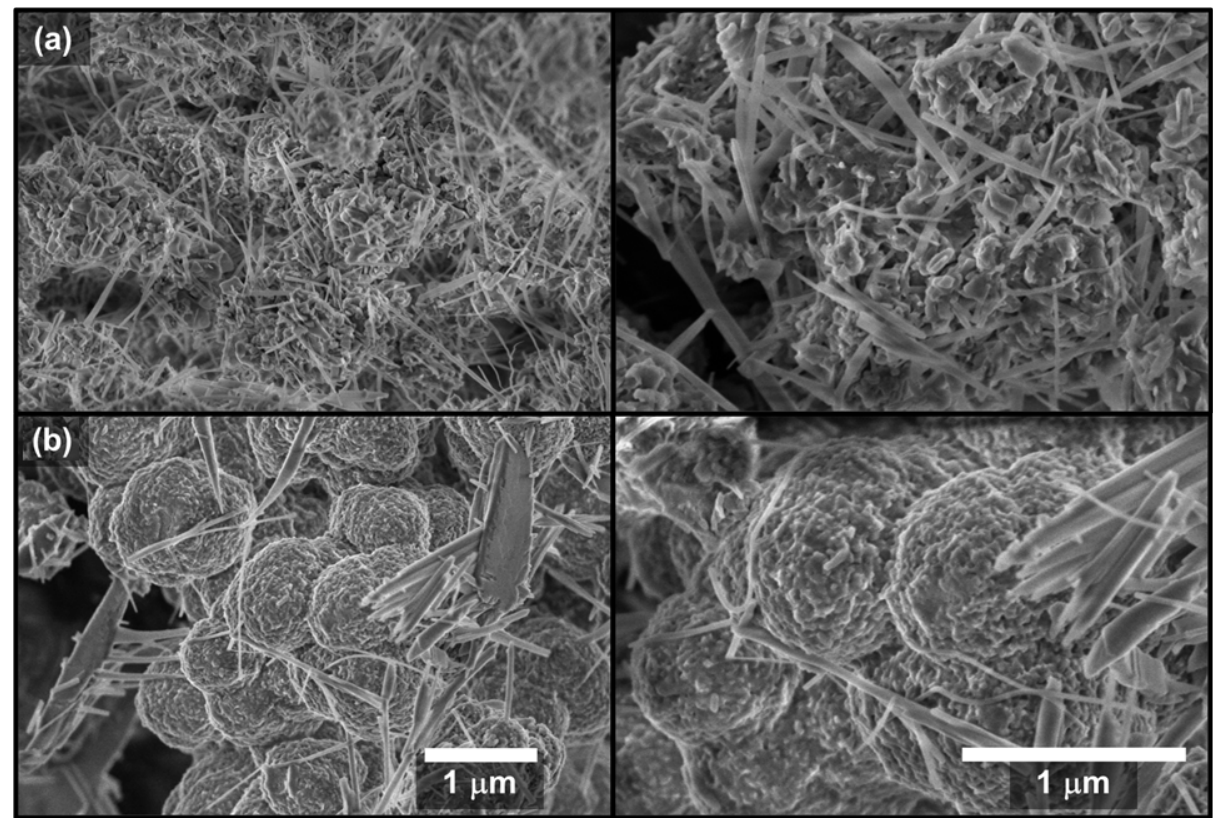
Figure 3. SEM micrographs of ( a ) PPA1 HT and ( b ) PPA16 HH-HH . Magnification of 25,000× and 50,000×, respectively.